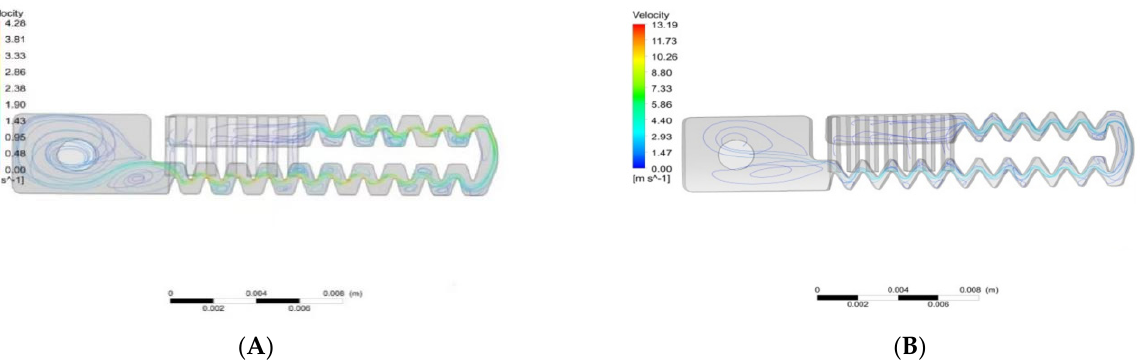
Figure 15. Three − dimensional diagram of the velocity distribution of the flow channel for 0.1 MPa. ( A ) Control group (before optimization). ( B ) Plan 3 (after optimization).